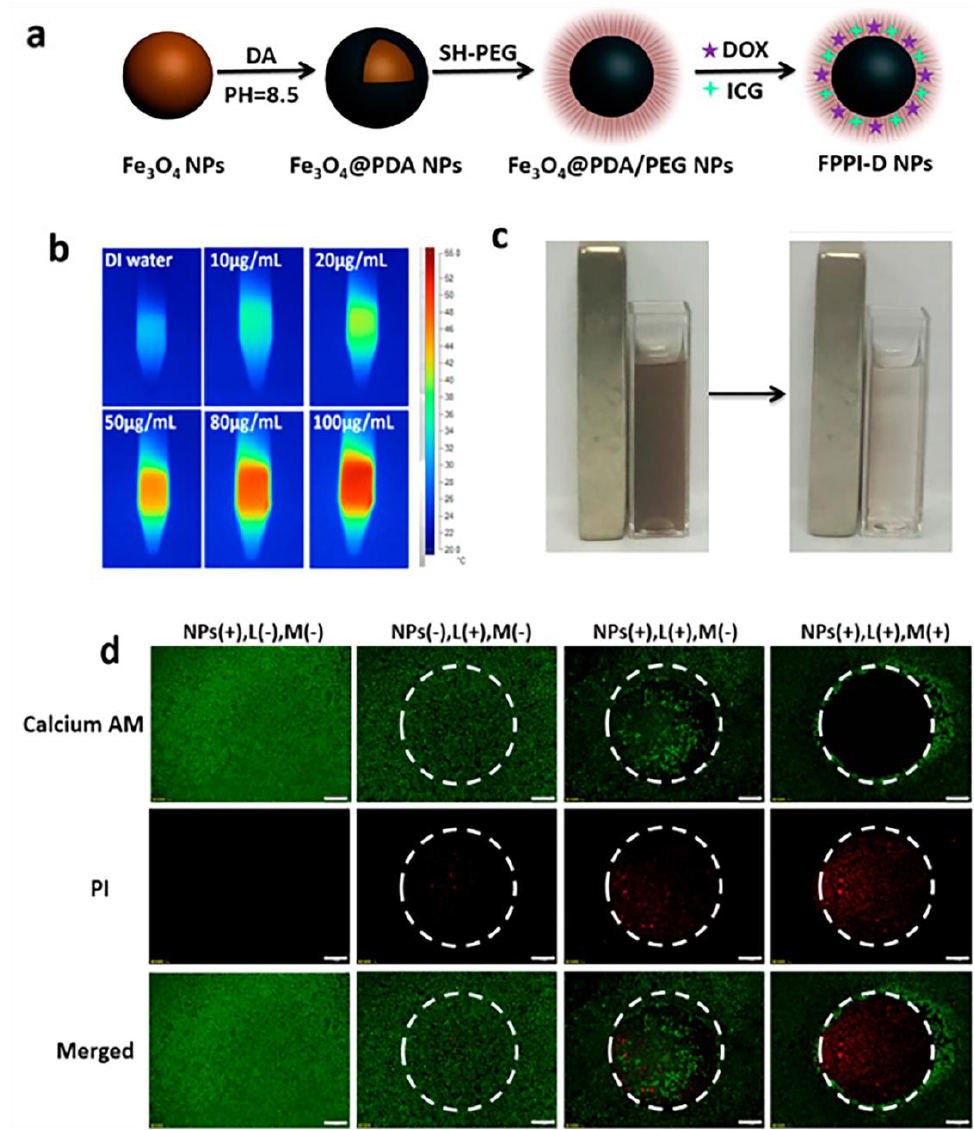
Figure 7. ( a ) Design of FPPI-DNPs. ( b ) Images from thermal imaging of test tubes containing samples of FPPI-DNPs at different concentrations. ( c ) FPPI-DNP aggregation in a magnetic field. ( d ) Live/dead cell staining following NPs, magnetic guiding (M), and NIR radiation therapy (L). The laser irradiation point is represented by the circular region in the image’s center. Scale bar: 500µm. Reproduced with permission from ref. [73] . Copyright © 2022, American Chemical Society.